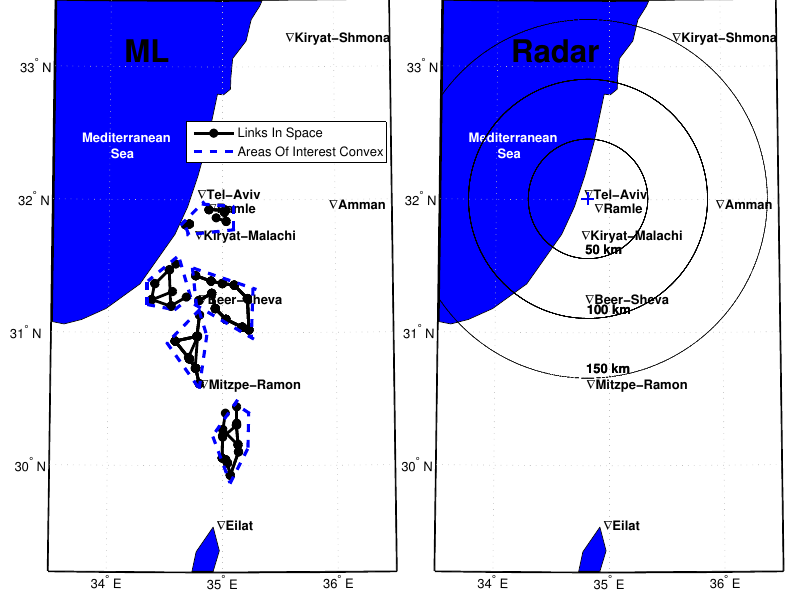
Figure 1. Left: 96 ML in space divided into 6 areas of interest. Black lines indicate the links, and the blue dashed lines indicate the convex of each area of interest. Right: the radar coverage area, where the blue “ + ” sign indicates the radar coordinates – Bet Dagan. The radar’s 50, 100 and 150km radius distances are also